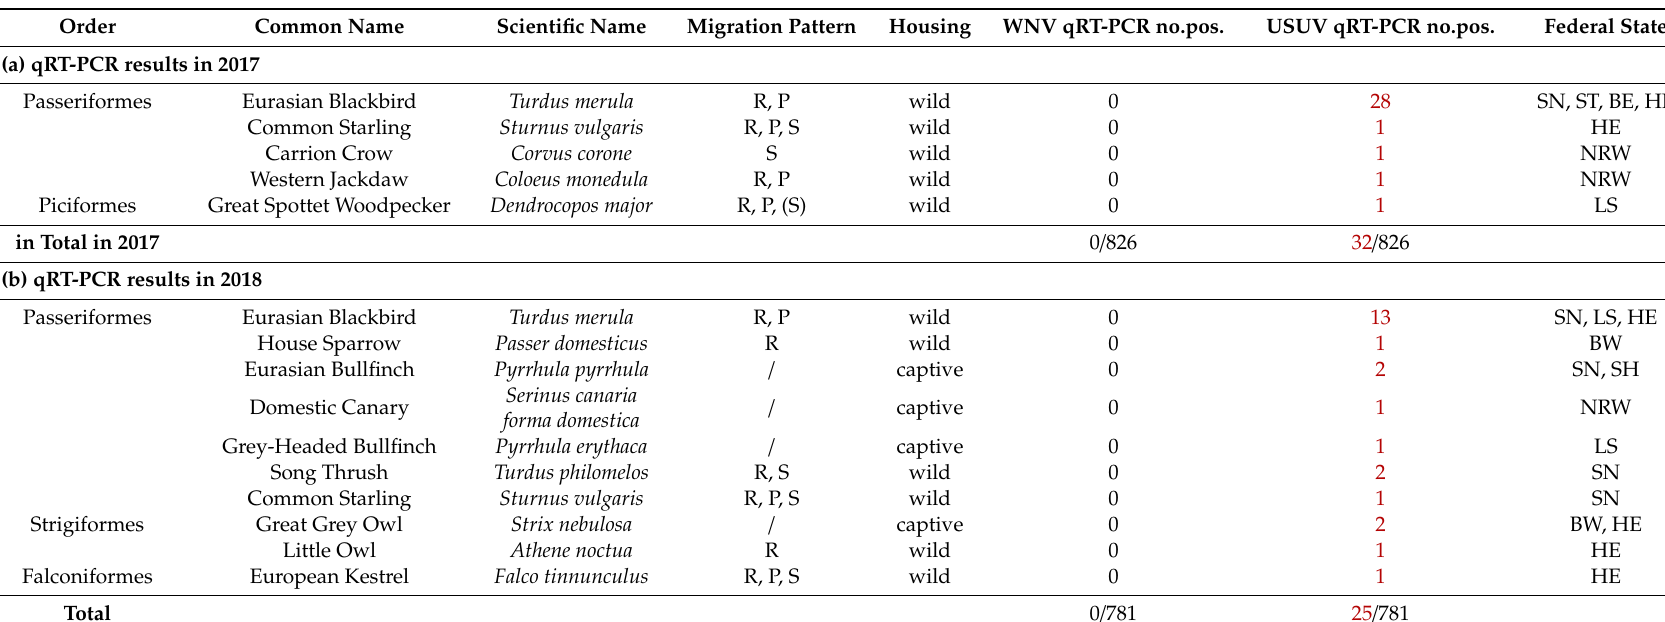
Table 2. Results of quantitative real-time polymerase chain reactions (qRT-PCR) in wild and zoo bird samples of the first sample panel in 2017 and 2018. Positive samples are highlighted in